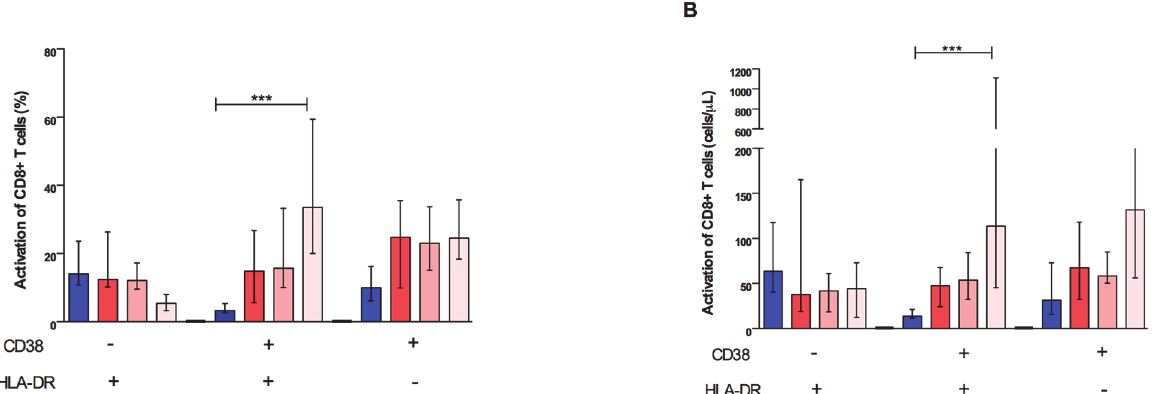
Fig 4. Activation of CD8+ T cells in dengue fever. (A) Percentage and (B) absolute numbers of three subpopulations (HLADR+, CD38+HLADR+, and CD38+) within CD8+ T cells in the peripheral blood from healthy controls (n = 17) and dengue fever patients (n = 74) at different days of symptoms: HLADR+, CD38+HLADR+, and CD38+. Only the dual positive subpopulation significantly increased during the course of dengue fever, either in their percentage or absolute numbers. * p < 0.05, *** p <